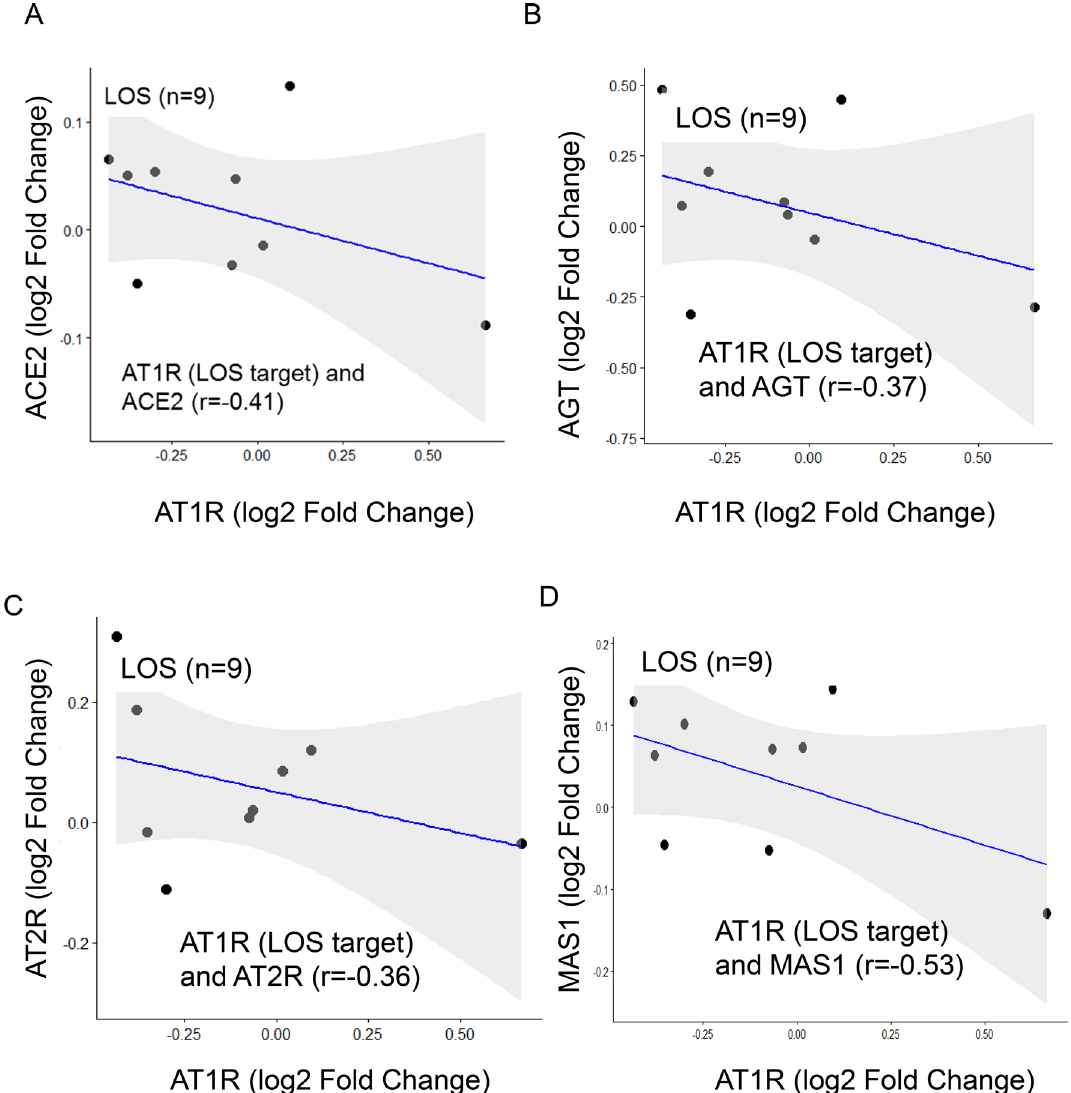
Figure 3. Negative Pearson correlation of RAS component to LOS treatment. ( A ) Negative correlation of AT1R with ACE2 (r = − 0.41). ( B ) Negative correlation of AT1R with AGT (r = − 0.37). ( C ) Negative correlation of AT1R with AT2R (r = − 0.36). ( D ) Negative correlation of AT1R with MAS1 (r = − 0.53). Calculation of correlation coefficient and testing the significance of the correlation coefficient were performed using R (* denotes P <